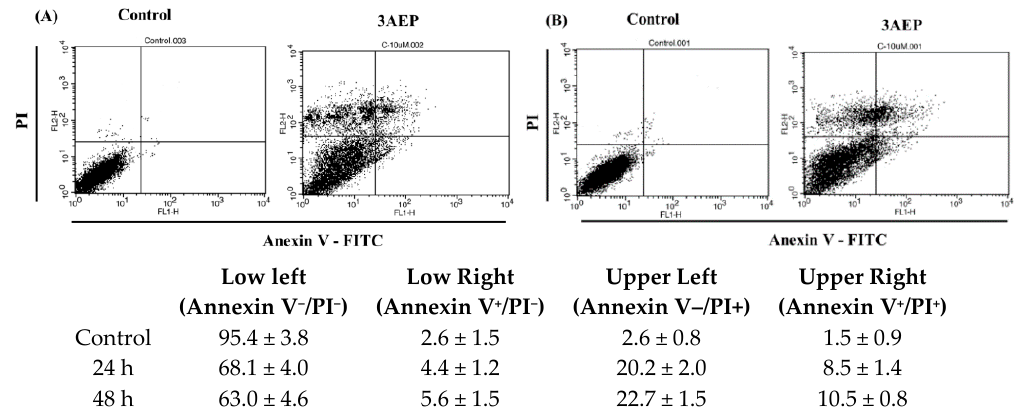
Figure 4. Flow cytometry analysis of 3AEP on HL-60 cells in 24 h ( A ) and 48 h ( B ). The results were expressed as the mean ± standard deviation (SD) of three replicates.